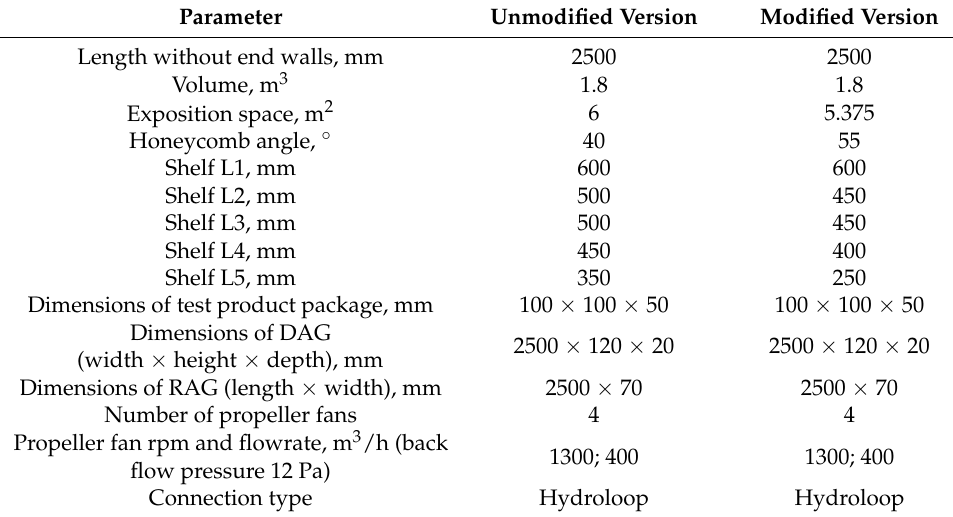
Figure 1. Scheme of the open-type refrigerated display cabinet: 3D view ( left ); 2D side view ( right ). Table 1. Characteristics of the open-type display cabinet (Figure 1).